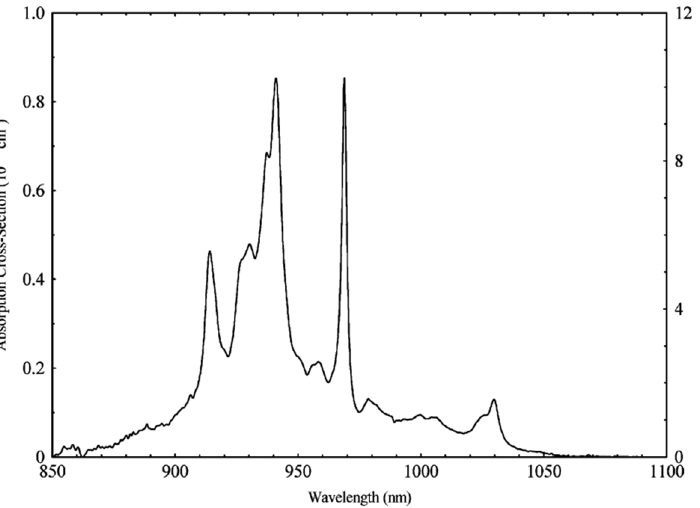
Figure 2. Absorption cross − section of Yb:YAG crystal (0.24 mm thick and 9.8% doping concentra- tion) as a function of wavelength for a crystal temperature of 300 K [12]. Reprinted/adapted with permission from Ref. [IEEE]. 2005, D. C.